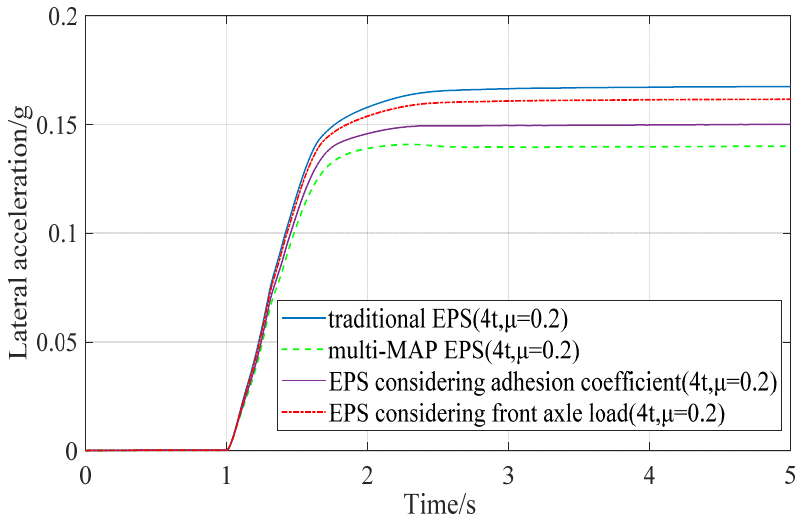
Figure 10. Comparison of lateral acceleration of different EPS.